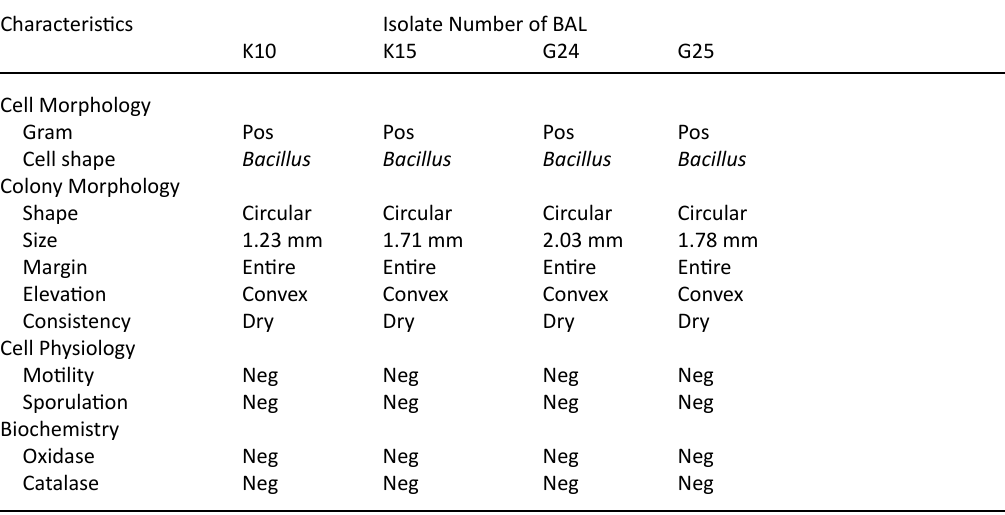
Table 3. Characterization of Lactic Acid Bacteria (LAB) isolated from kefir grain and goat milk kefir